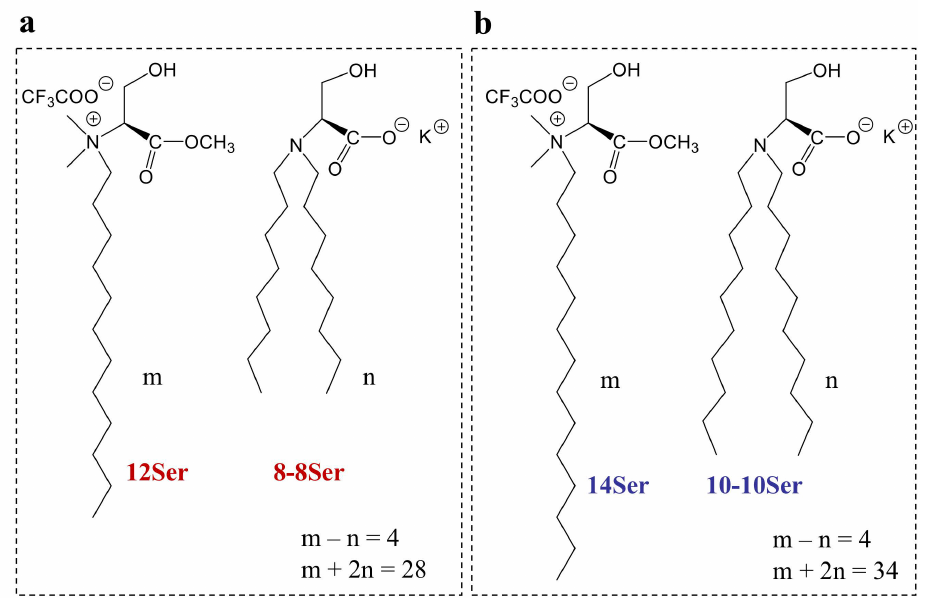
Figure 1. Molecular structure of the serine-based surfactants that form the catanionic mixtures: ( a ) 12Ser/8-8Ser system; ( b ) 14Ser/10-10Ser system. The letters n and m represent the number of C atoms in the hydrocarbon chains; m − n is thus the chain length asymmetry and m + 2n is the total chain